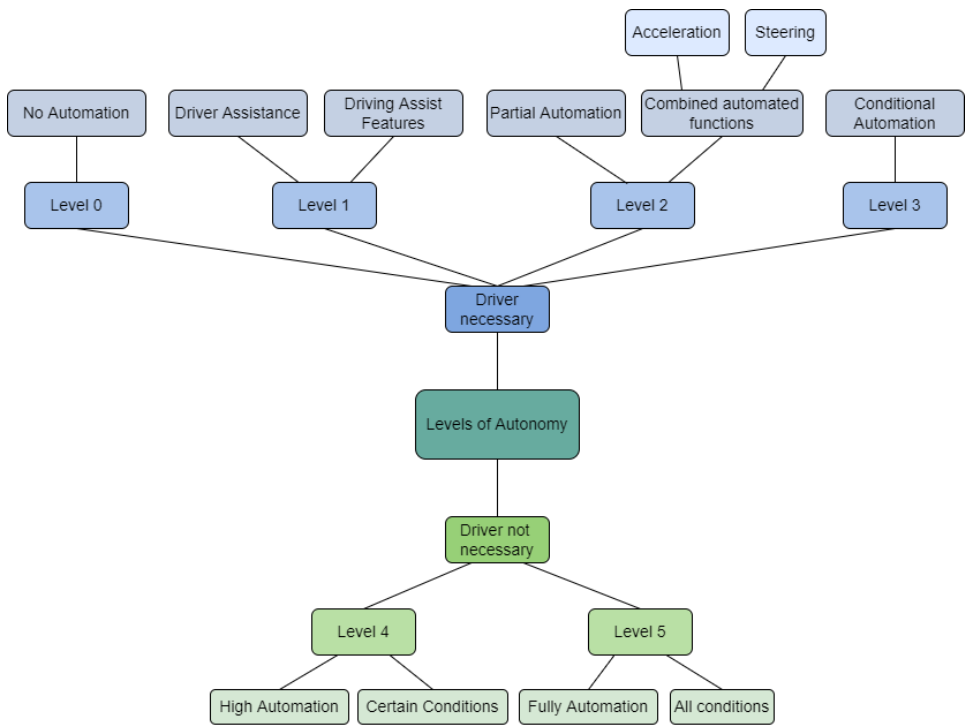
Figure 3. Levels of